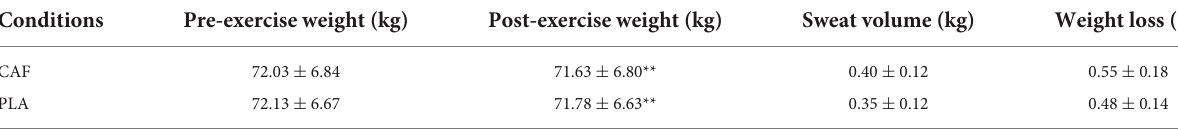
TABLE 1 Changes in sweat volume and weight loss of the participants during trials.